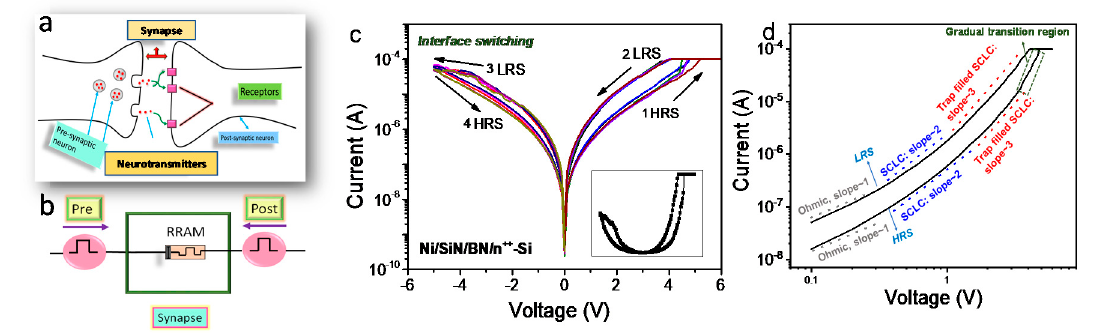
Figure 3. Synaptic characteristics of Ni/SiN/BN/n ++ -Si device: ( a ) schematic of the neuron and synapse network, and ( b ) artificial synaptic memristor. ( c ) Interface switching type I–V curves. ( d ) Log-log fitting curves of the positive region.